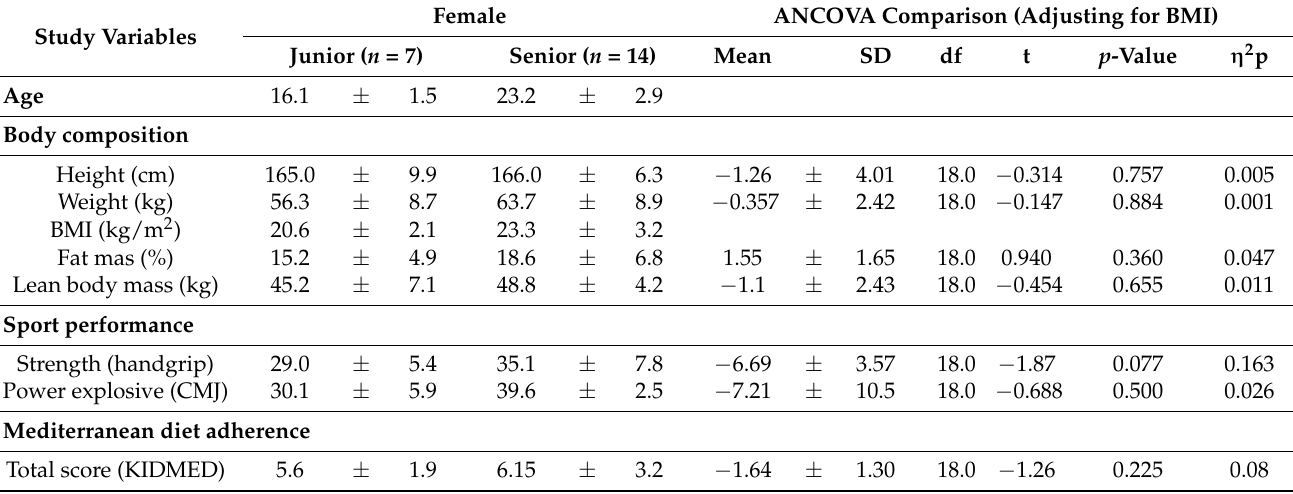
Table 3. Female beach handball players’ descriptive and comparison (junior vs senior).